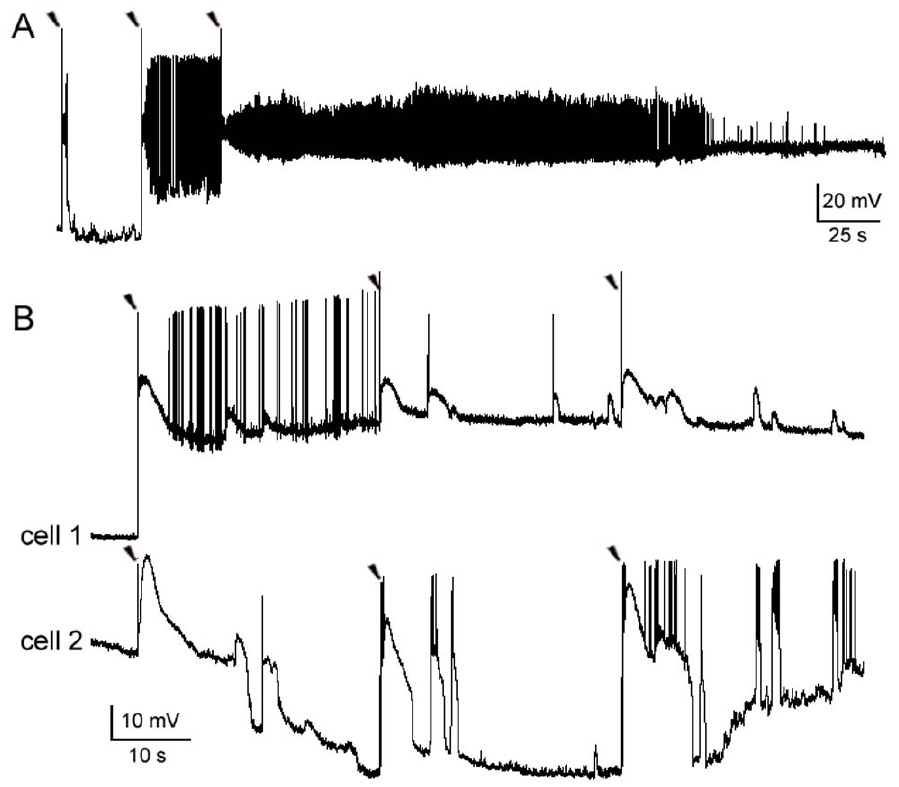
Figure 5. Tonic firing and supra-synchronization. A. A tonic firing recorded from a PC. After 500 nM A b 42 was applied for more than 30 min., tonic firing was induced in a PC immediately after the 2 nd stimulus was delivered. The membrane potential thereafter was found to be depolarized to 2 20 mV for more than 10 min. (200 s recording was shown). B. Synchronization during and after tonic firing. In a PC-pair recording exposed to 500 nM A b 42 for 30 min., a stimulating pulse in cell 1 initially provoked tonic AP firing. Its membrane potential became depolarized similar to A . This highly depolarized state remained stable without AP firing for more than 10 min. (not show all). Cell 2 initially experienced hyperpolarization. Nevertheless, almost all depolarizing responses, lasting for up to 10 s, showed synchronization between the two neurons.